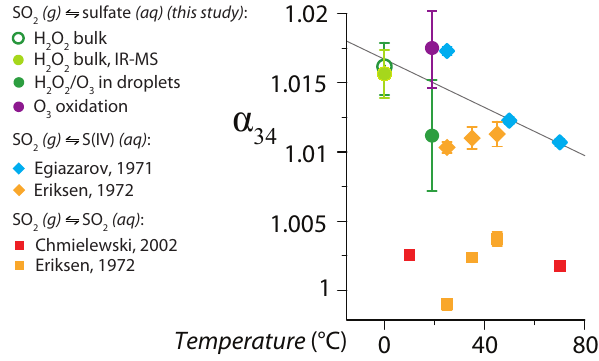
Fig. 7. Temperature dependence of fractionation during aqueous oxidation of SO 2 by H 2 O 2 and O 3 . Error bars are the 1 σ standard